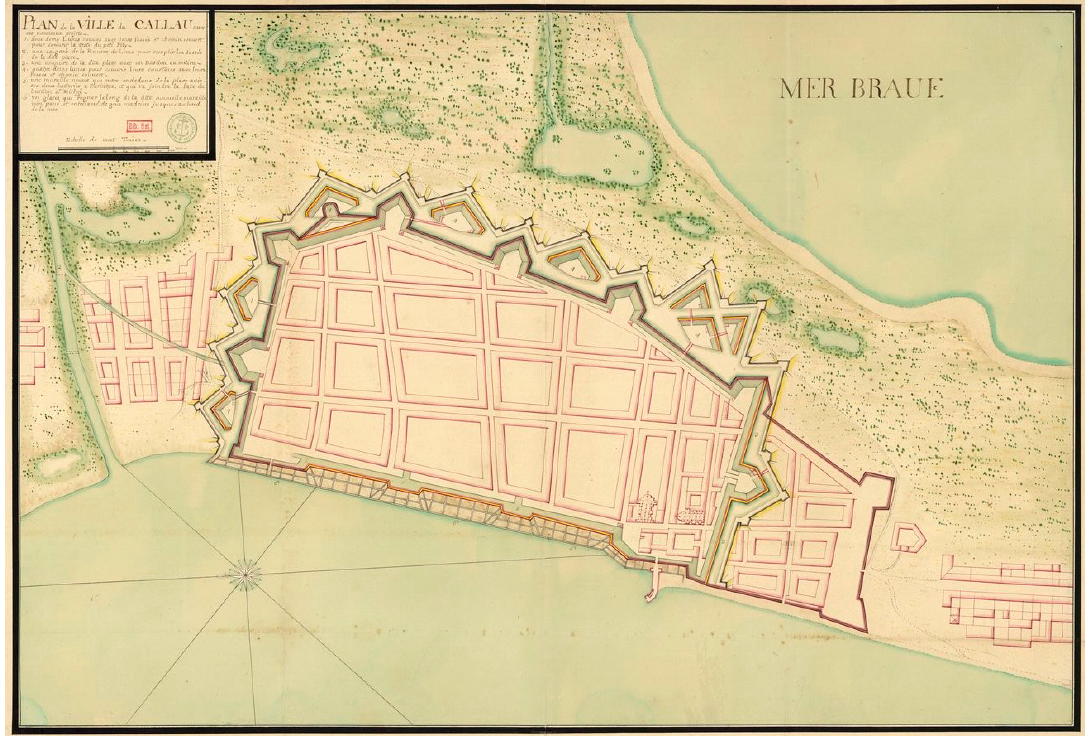
Figure 8. Callao: project of the walls and of their protection on the sea side formed by wooden board boxes filled with well-arranged stones [35]. Courtesy: Bibliothèque nationale de France.